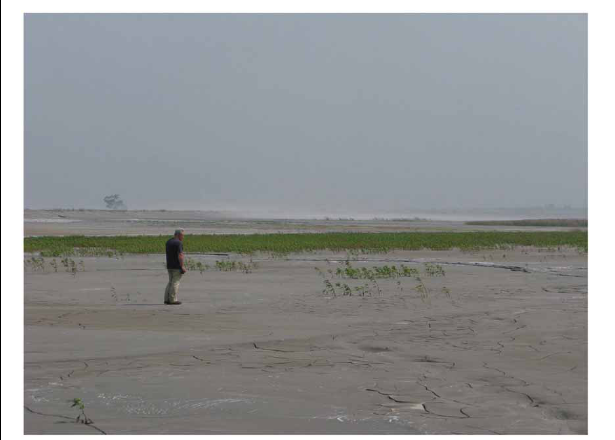
FIGURE 2 | Chambishi: global view with dust storm at the background.